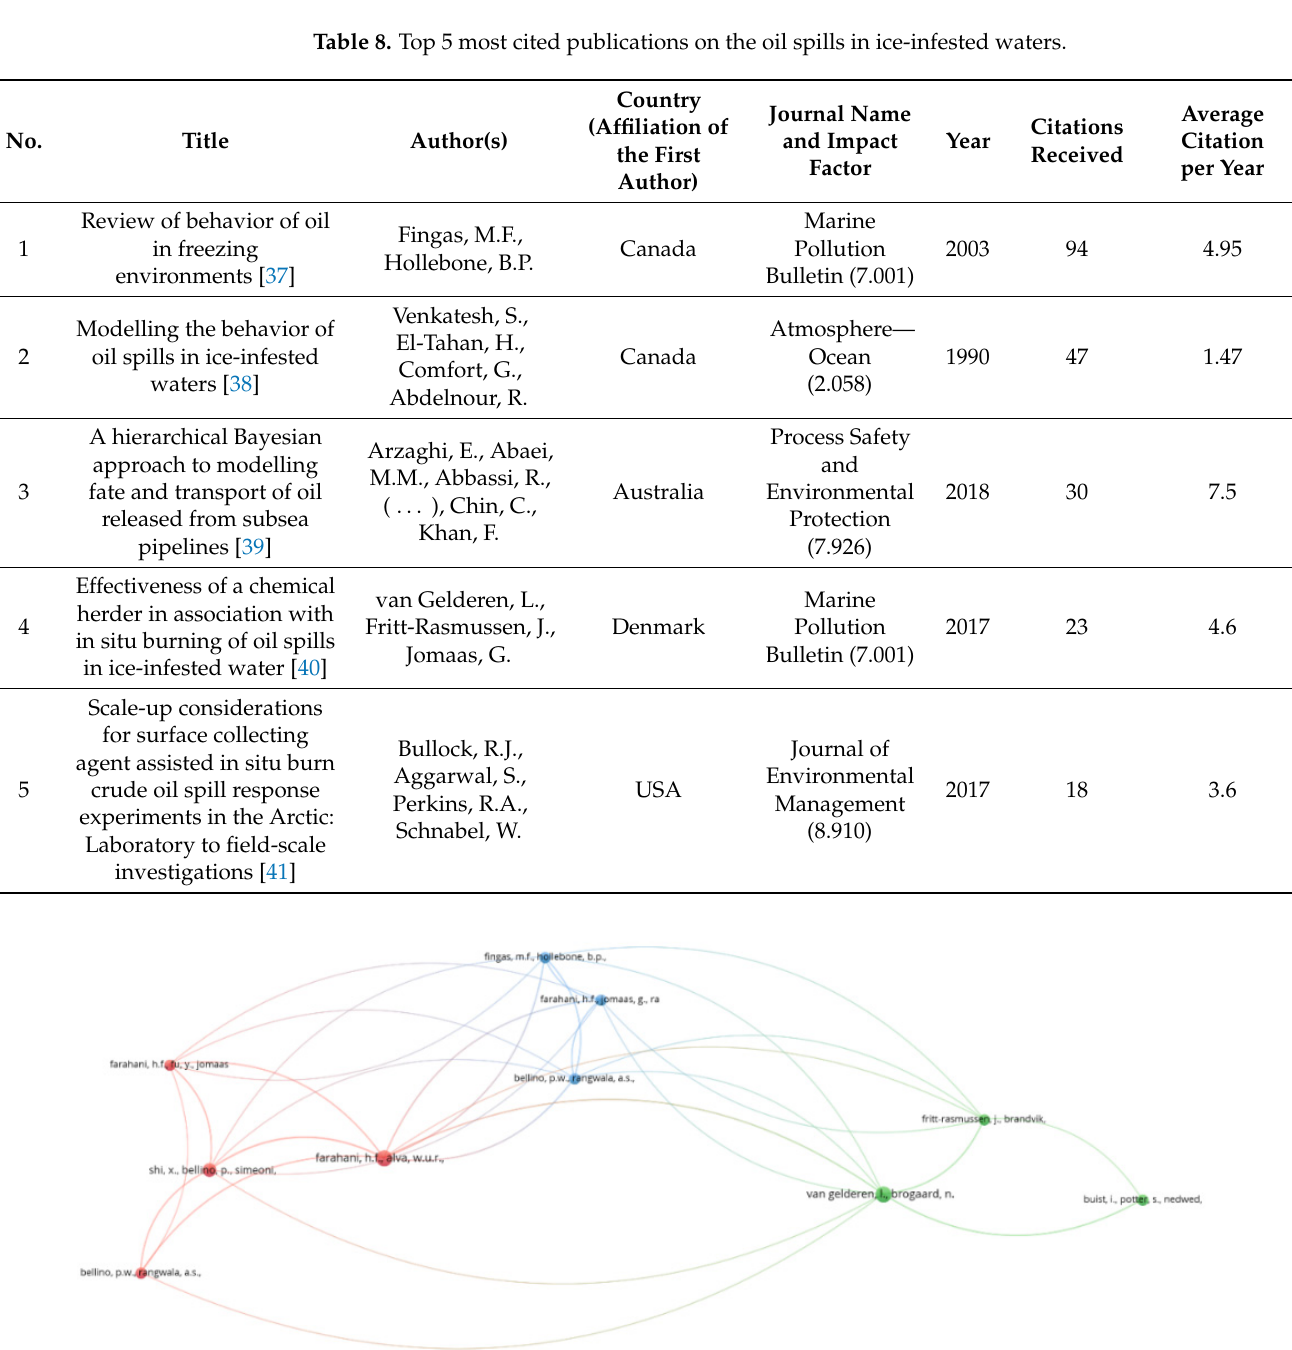
Figure 5. Co-citation analysis of cited authors used in publications on the oil spills in ice-infested waters. Figure 7 represents a terms analysis of the oil spill publications in ice-infested waters with the time information. The color of each term shows the average year of the publication in which the term was used. In the terms analysis, the terms from the 1990s are grouped with blue color, the terms that were used in the 2010s are marked with a green, whereas the terms that were commonly used in the 2020s are shown with yellow color. The term “ice-infested waters” is labeled as green, showing that the publications on the topic of